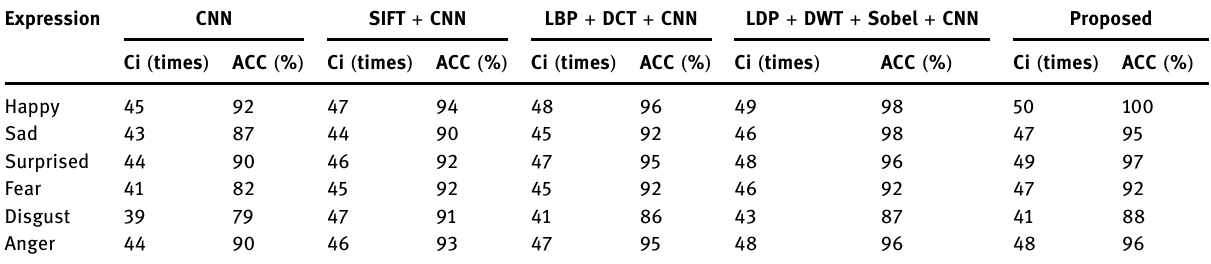
Table 1: Result comparison of di ff erent algorithms in the CK + dataset, where Ci means correct identi fi cation, ACC means recognition rate